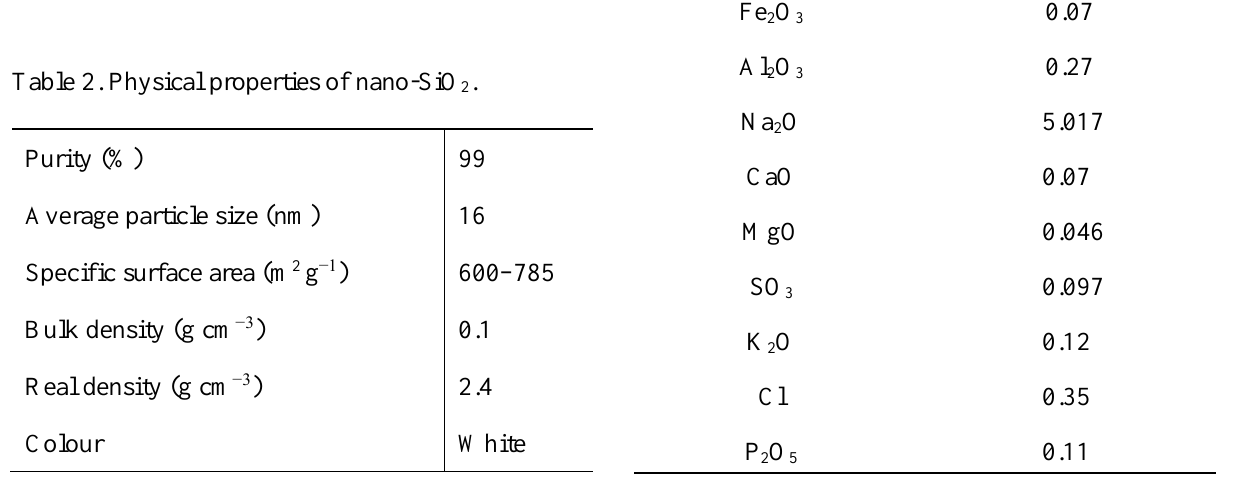
Table 2. Physical properties of nano-SiO 2